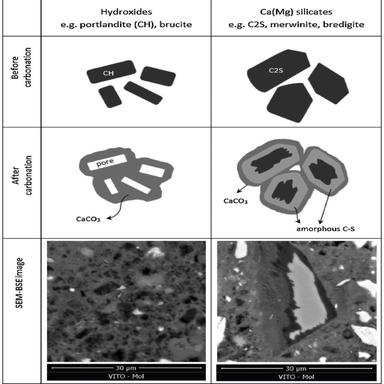
Microstructures of different mineral phases in the BOFS after 240 min of carbonation curing at 1.3 bar with 100 % CO2.